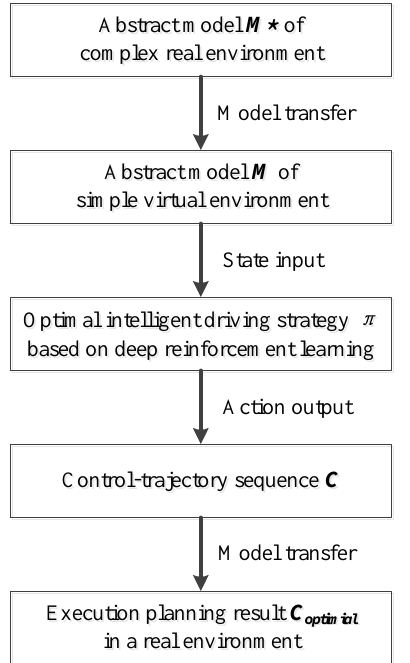
Figure 6. Block diagram of model transfer trajectory planning based on deep reinforcement learning (DRL-MTTP). Algorithm 2. Model transfer trajectory planning based on deep reinforcement learning (DRL-MTTP) frame.